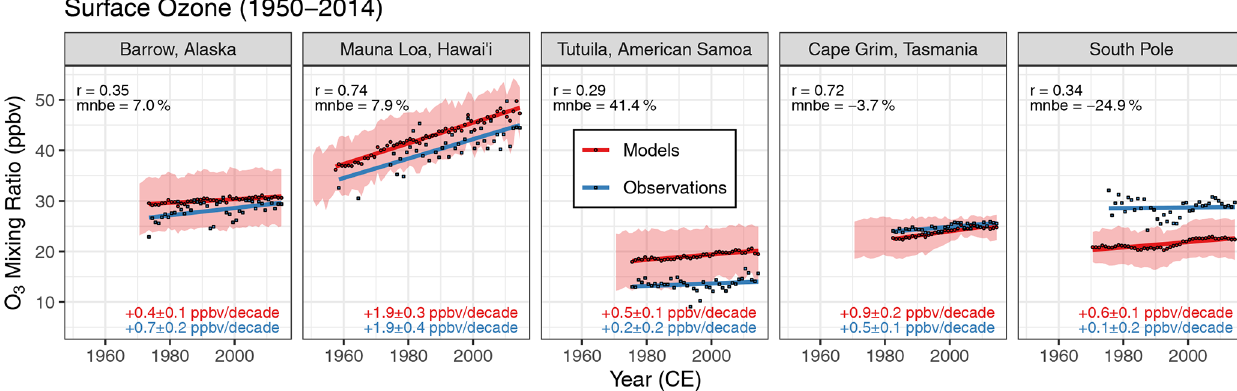
Figure 3. Comparison of annual mean surface observations with the multi-model mean at five stations: Barrow, Alaska, USA (71.3 ◦ N, 156.6 ◦ W; 11ma.s.l.), Mauna Loa, Hawai‘i, USA (19.5 ◦ N, 155.6 ◦ W; 3397ma.s.l.), Cape Matatula, Tutuila, American Samoa (14.2 ◦ S, 170.6 ◦ E; 42ma.s.l.), Cape Grim, Tasmania, Australia (40.7 ◦ S, 144.7 ◦ E; 94ma.s.l.) and the South Pole (90.0 ◦ S, 59.0 ◦ E; 2840ma.s.l.). The models are sampled from the surface level, except for Mauna Loa, which is sampled at 680hPa. The pink shading represents the multi-model mean and ± 1 standard deviation at each location. The red circles indicate the multi-model mean sampled at the month of the observations. The blue squares represent the observations. The solid lines show an ordinary least-squares regression for the multi-model mean and the observations, with the respective slope printed in the lower right of the panel. The temporal correlation ( r ) and mean normalized bias error (mnbe) are shown in black for each